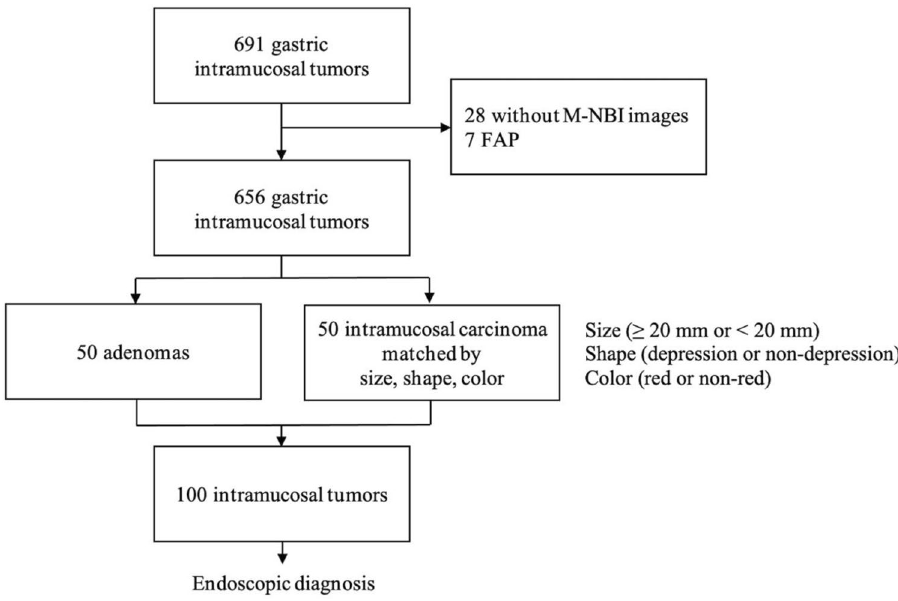
Figure 3. Patient enrollment and extraction. In total, 50 adenomas and 50 intramucosal carcinomas matched by tumor size (≥ 20 mm or < 20 mm), shape (depression or non-depression), and color (red or non-red) were extracted. Endoscopic diagnosis was performed on 100 of these intramucosal